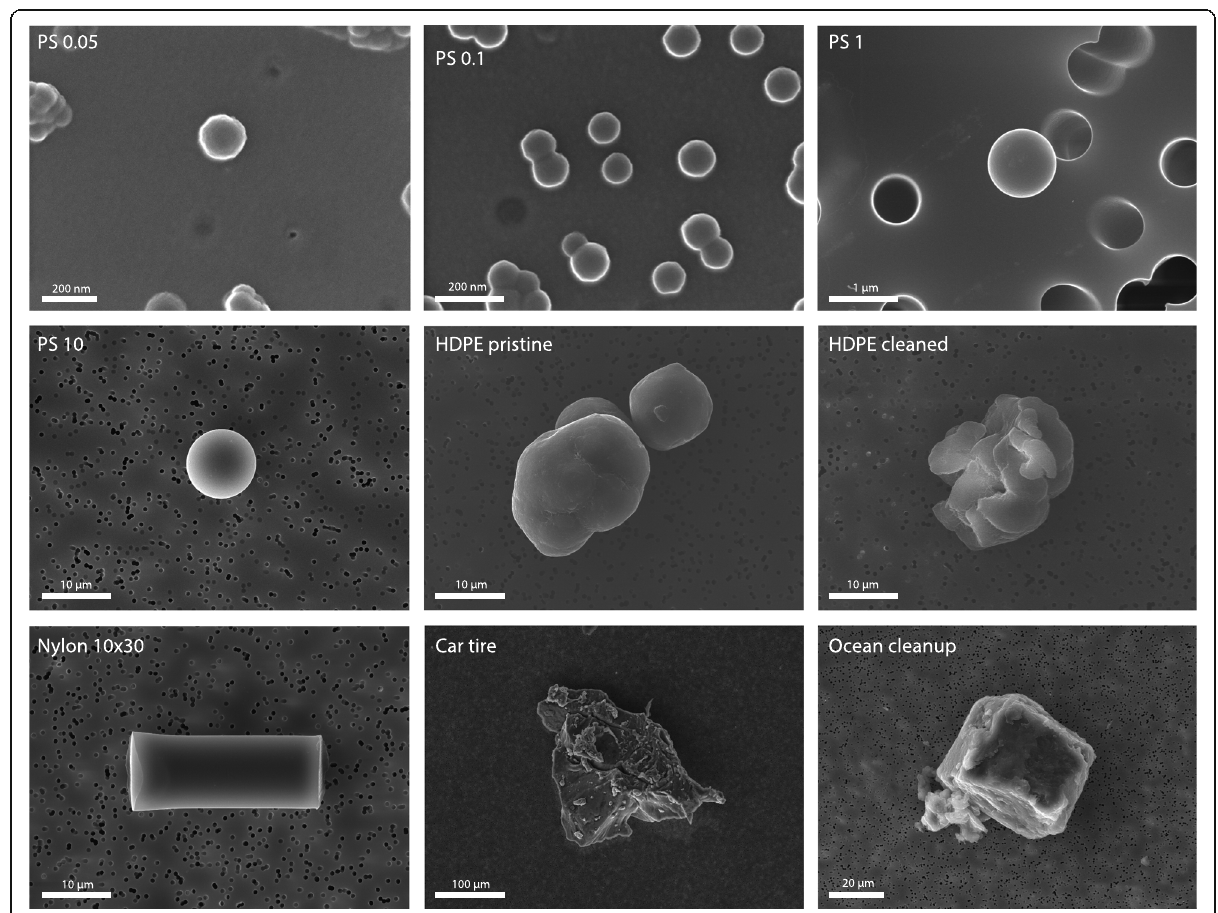
Fig. 1 Characterization of micro- and nanoplastic particles by scanning electron microscopy (SEM). Representative images of polystyrene (PS) spheres of 0.05, 0.1, 1 and 10 μ m, high density polyethylene (HDPE) fragments, the nylon fiber of 10 × 30 μ m, car tire and ocean cleanup